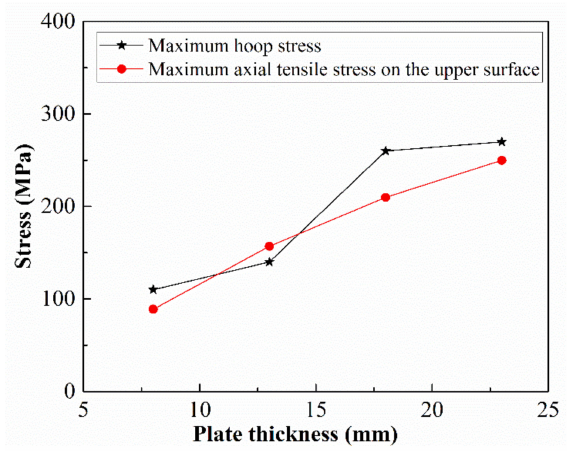
Figure 16. E ff ect of the plate thickness on the residual